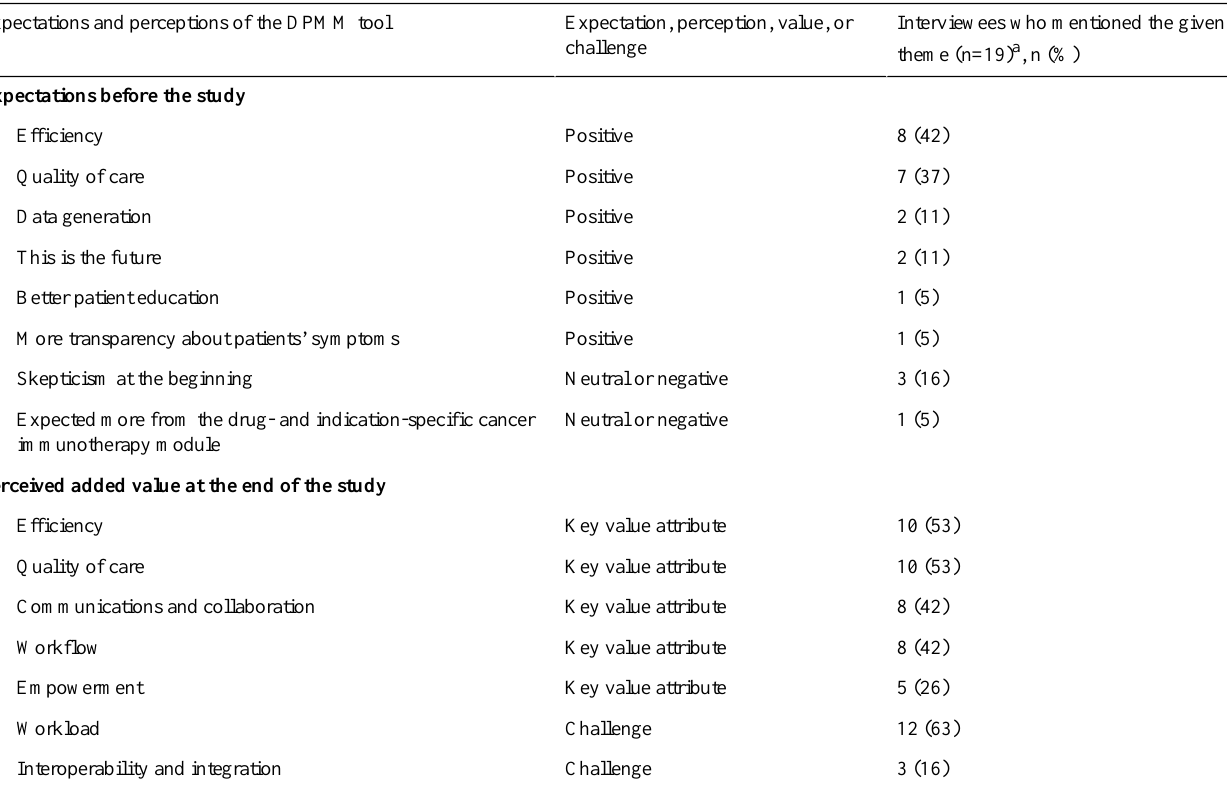
Table 6. Expectations and perceived added value of the digital patient monitoring and management (DPMM) tool from qualitative health care professional